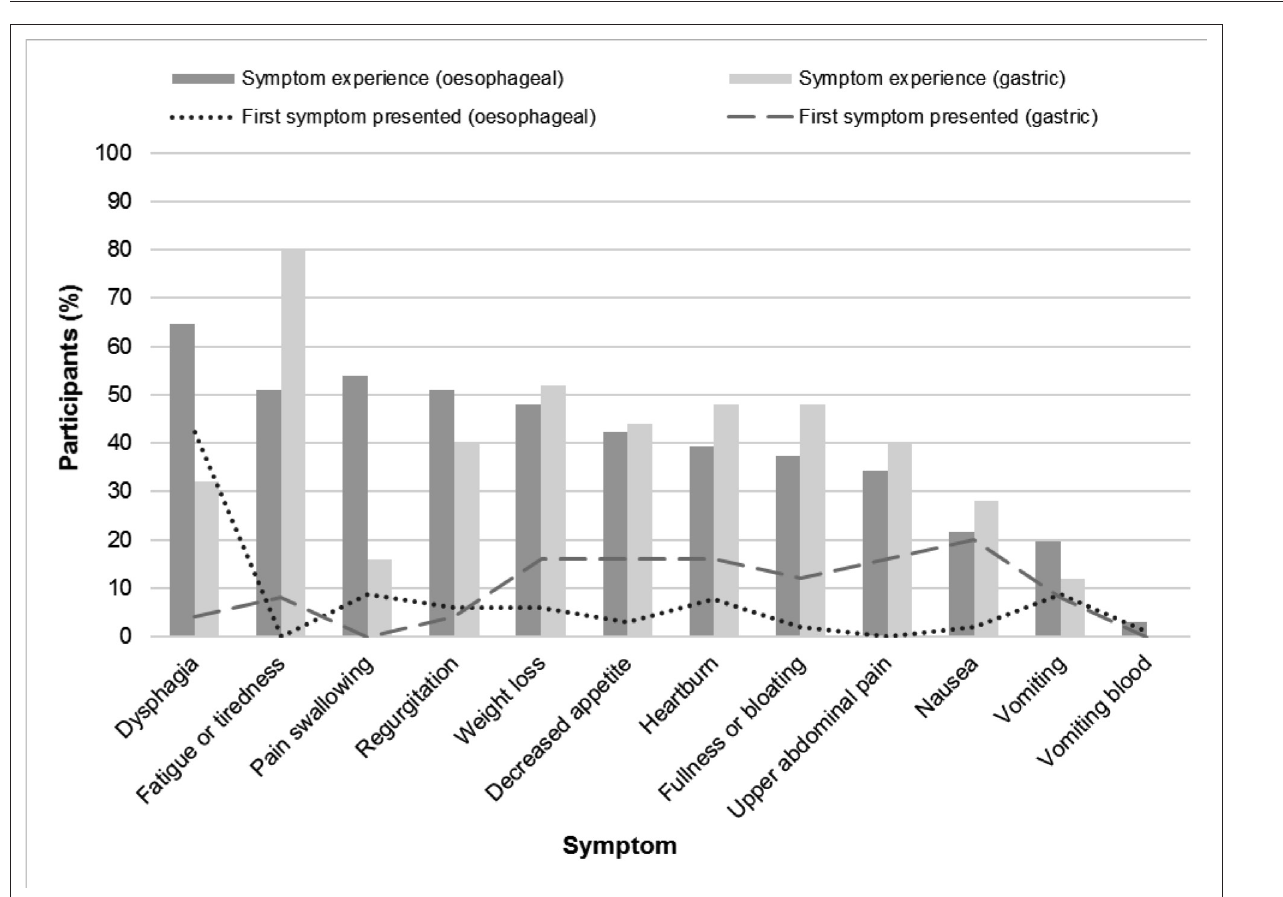
Figure 2 First symptom presented to the GP compared with symptom experience before diagnosis, stratified by cancer